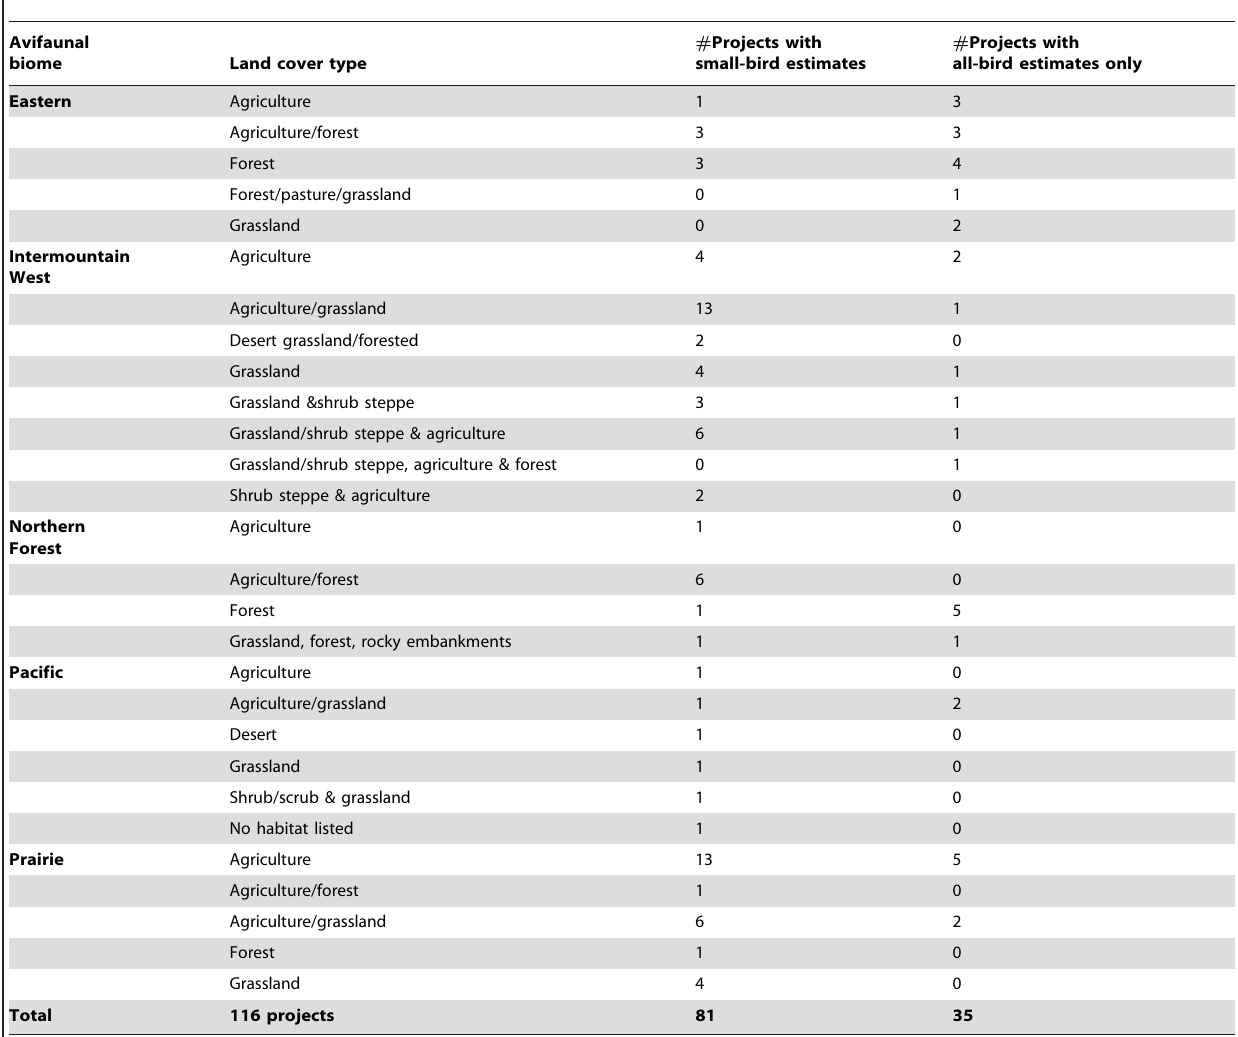
Table 1. The land cover type associated with studies of collisions of birds with wind turbines at wind energy facilities in geographically distinct avifaunal biomes, for studies that reported small-bird and all-bird only estimates of fatality rates.